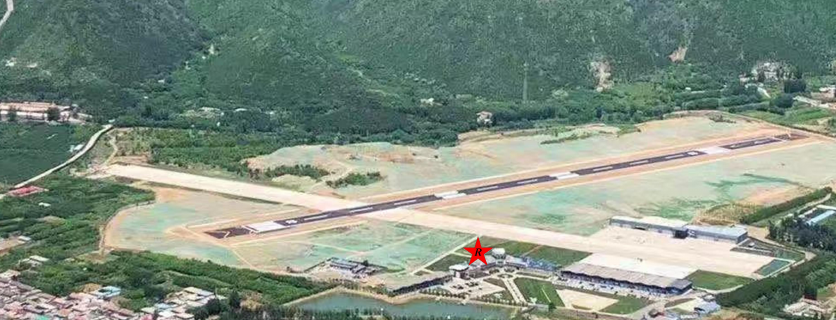
Figure 5. The actual experiment scene at a civil airport in China: an aerial map of the studied airfield, with the FOD millimeter-wave radar system’s location indicated by the letter R